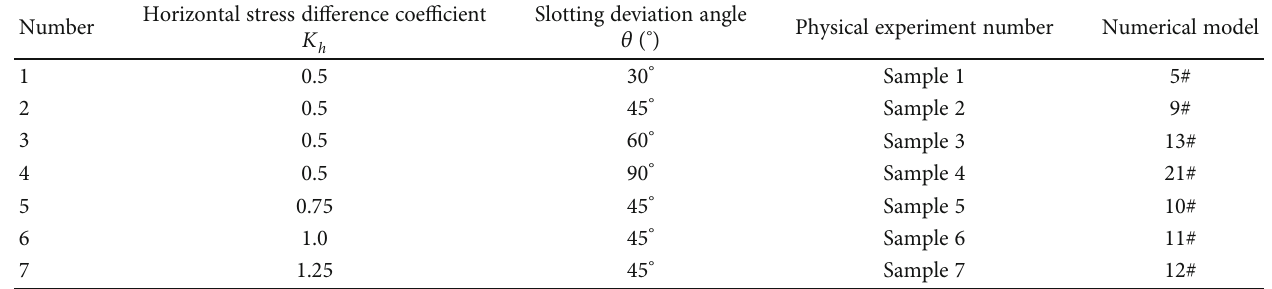
Table 3: Numerical model and corresponding physical experiment